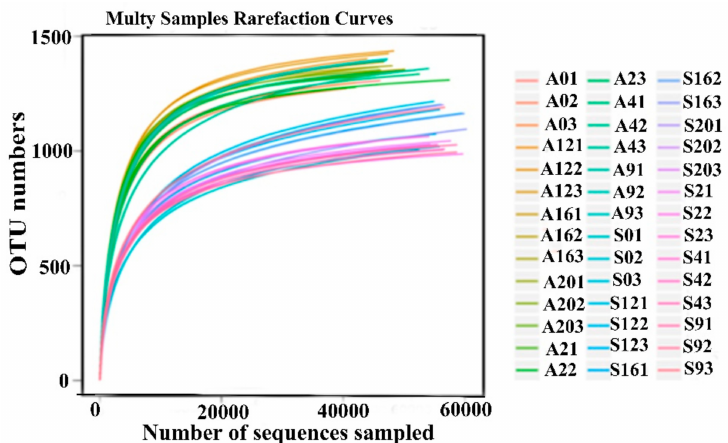
Figure 1. Rarefaction analysis of the di ff erent samples. Rarefaction curves of the operational taxonomic units (OTUs) clustered at a 97% sequence identity across the di ff erent groups. A represents the high-forage (HF) group samples, and S represents the high-concentrate (HC) group samples. The last number of each sample (1, 2 and 3) represents three repetitions, and the numbers in the front represent the di ff erent time points. For example: A01, A = HF group, 0 = 0 h and 1 = first repetition and S01, S = HC group, 0 = 0 h and 1 = first